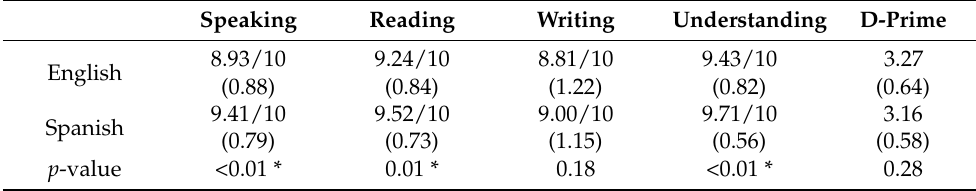
Table 1. Self-rated proficiency and lexical decisions scores (standard deviations in parentheses).